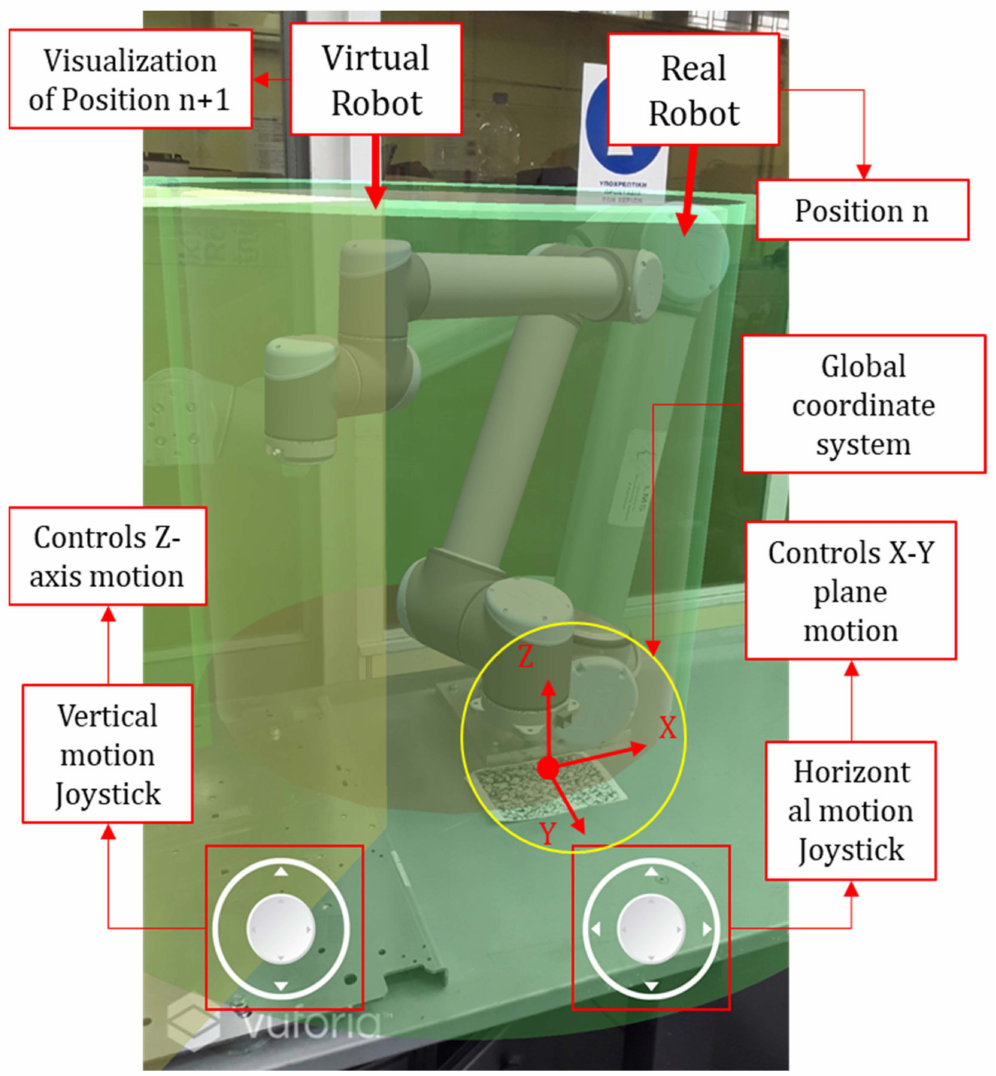
Figure 5. AR visualization of the robot safety zones and the next robot